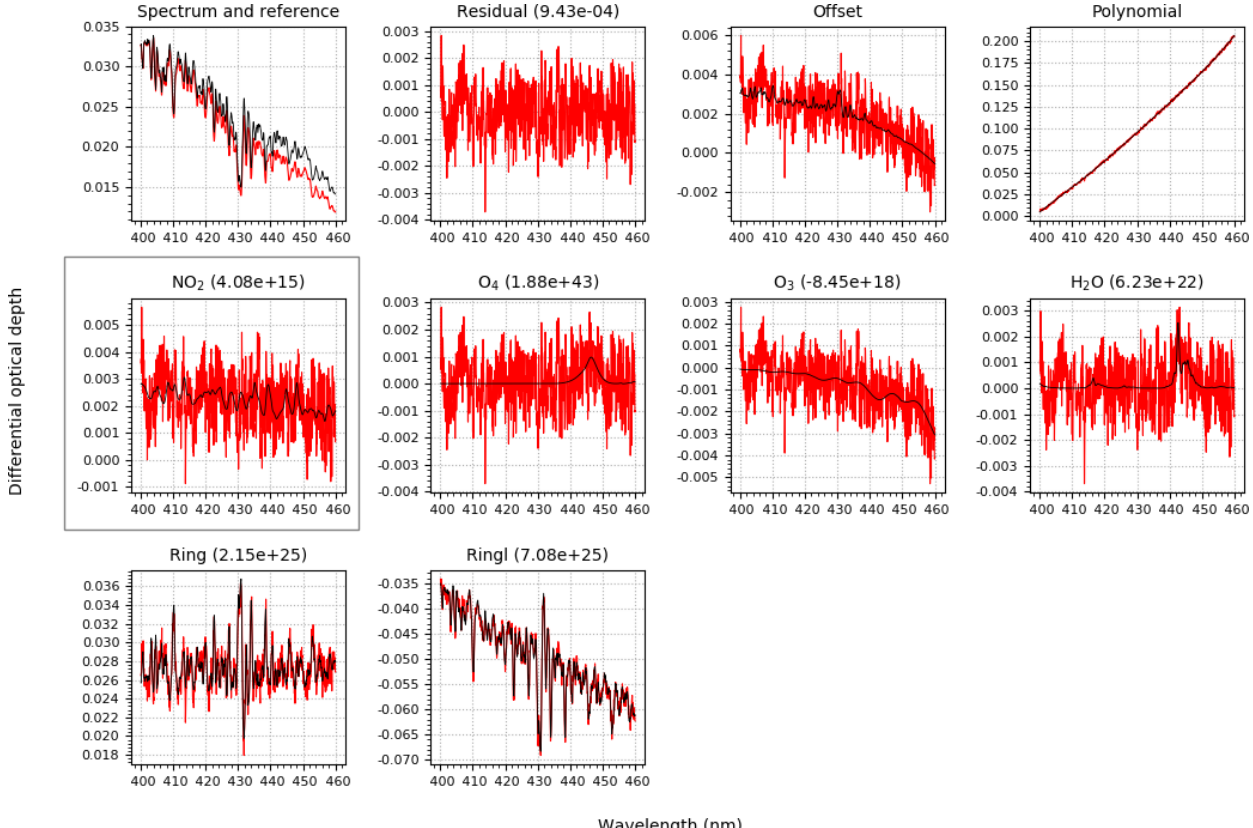
Figure A1. Example fit result of the QDOAS analysis (Instrument A: west side, upwind; 11:59:11UTC, 10 May 2019). The measured optical densities of different absorbers are depicted in red, whereas the fit results are depicted in black. The values in the titles refer to the resulting slant column densities in moleccm − 2 . The error in the NO 2 fit amounts to 0 . 53 × 10 15 moleccm − 2 .